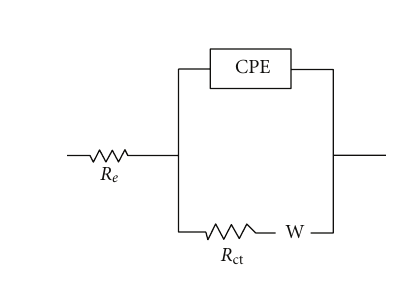
Figure 3: Equivalent electrical circuit (EEC) used to fit impedance data for low-nickel SS in a SCP